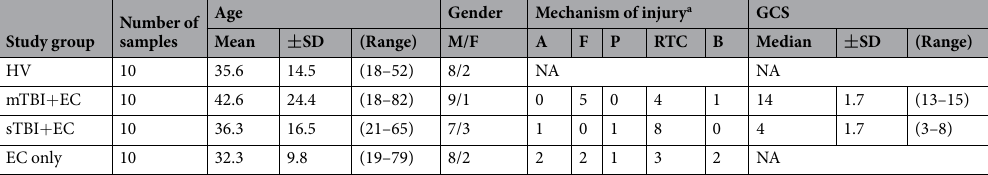
Table 3. Demographic characteristics of the study participants. a Mechanism of injury: A, assault; F, fall; P, penetrating; RTC, road traffic accident; B, other blunt; NA: Not